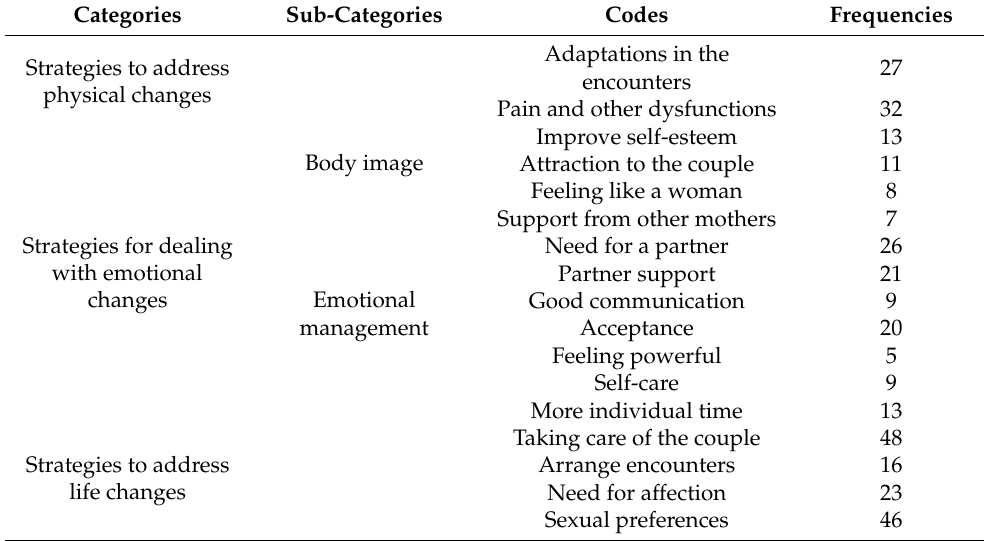
Table 4. Strategy categories and